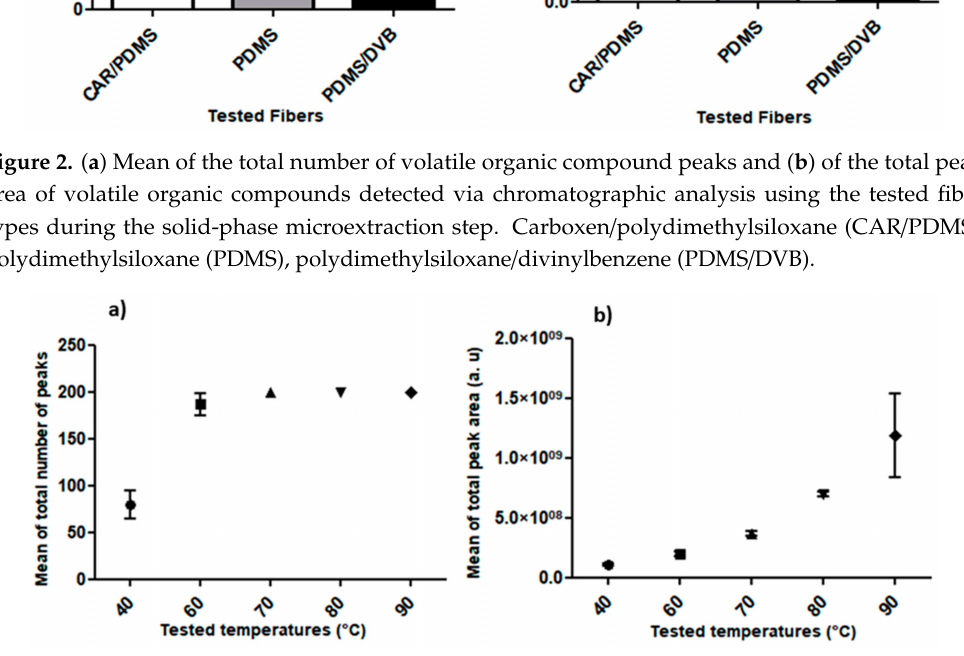
Figure 3. ( a ) Mean of the total number of volatile organic compound peaks and ( b ) of the total area of volatile organic compound peaks detected via chromatographic analysis using a PDMS / DVB fiber under di ff erent temperatures (40 ◦ C, 50 ◦ C, 60 ◦ C, 70 ◦ C, 80 ◦ C, and90 ◦ C) for 40 min during the solid-phase microextraction step.